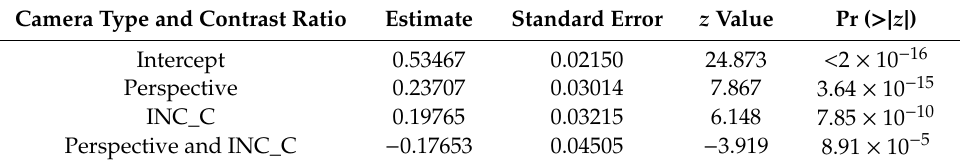
Table 14. Logistic regression analysis results of the additive model using the variables camera type and contrast ratio, allowing